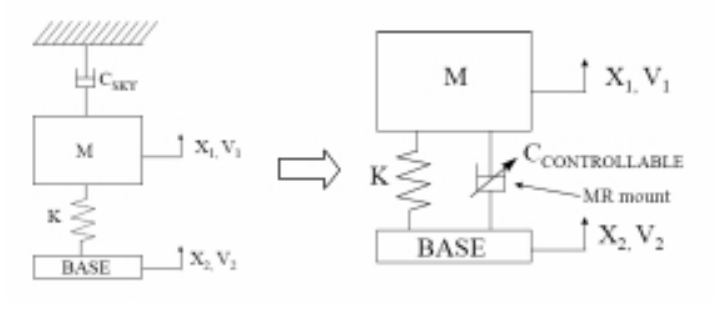
Fig. 4. Ideal Skyhook configuration is adapted for a semiactive suspension